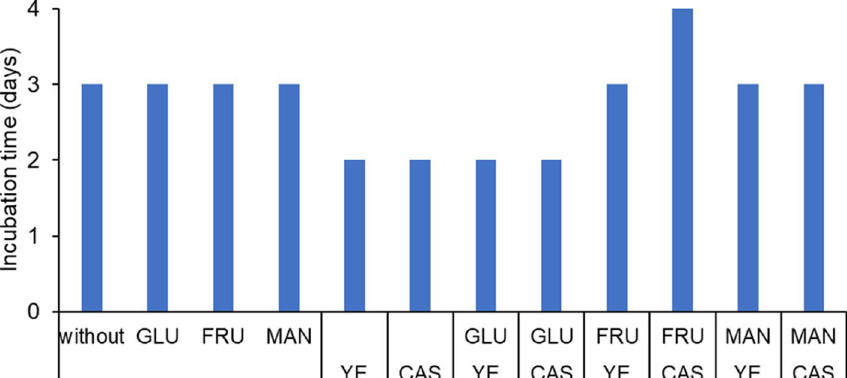
Fig. 7 Effect of incubation time on molar VA yield (%) produced from 5 mM FA by P. aromaticivorans AR20-38 at 20 °C in MM supplemented